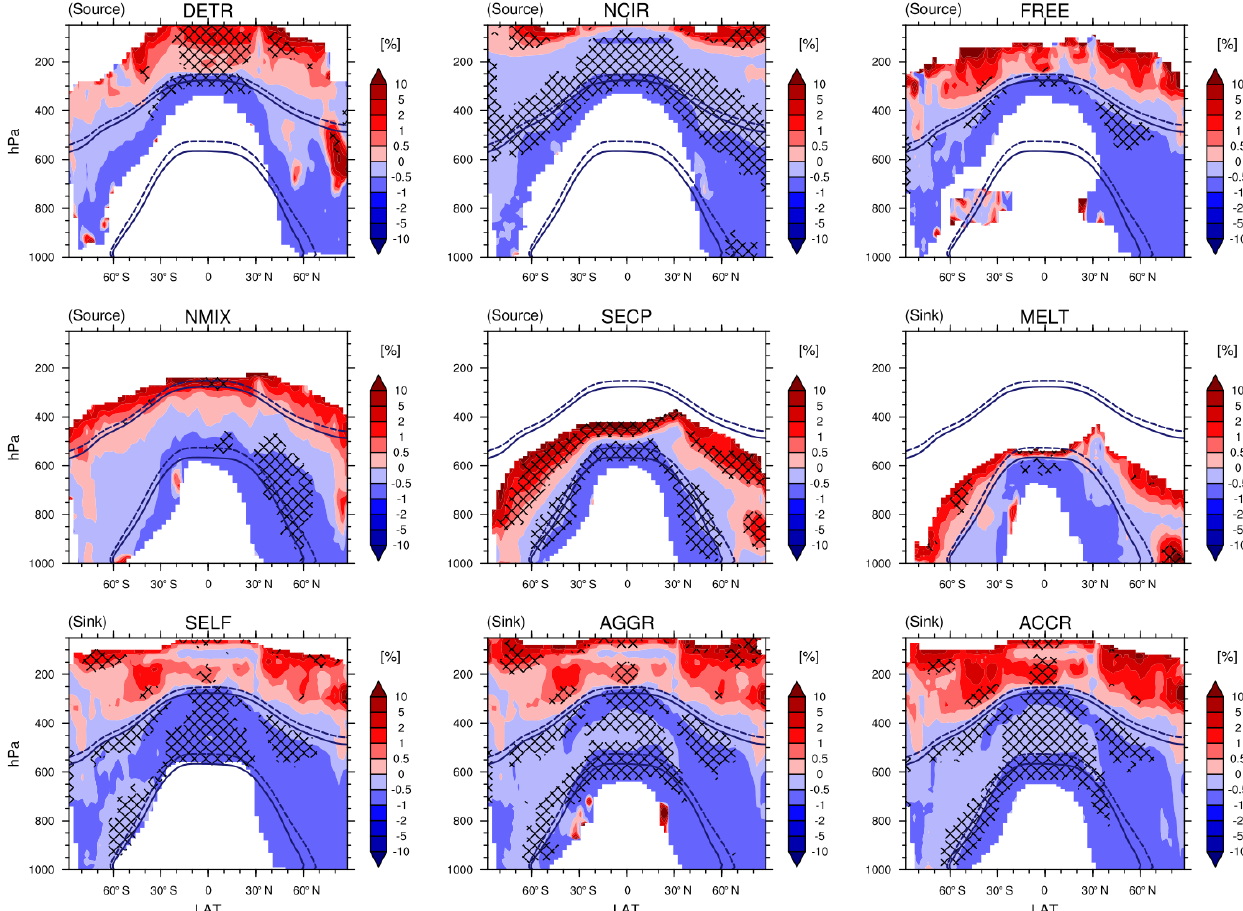
Figure 9. Percentage changes of the tendencies associated with ICNC microphysical processes in cold clouds in FUT with respect to REF. They are computed with daily means and are shown where REF daily means are > 10 − 5 m − 3 s − 1 . The hatched pattern indicates areas with a significance level of 90%. The isotherms at 0 and − 35 ◦ C are annual means in REF (solid line) and in FUT (dashed